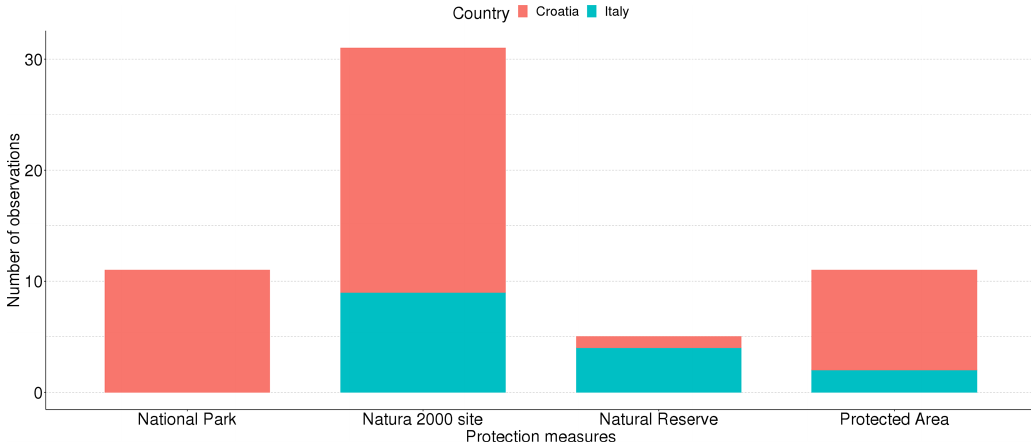
Figure 5. Protection measures applied to natural reefs in Croatia and in Italy.